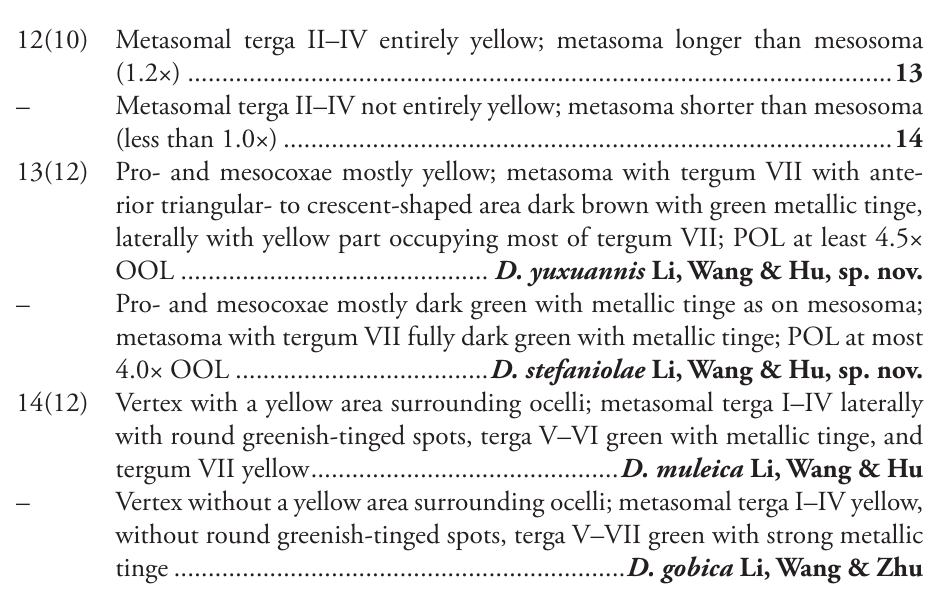
Metasomal terga II–IV entirely yellow; metasoma longer than mesosoma – Metasomal terga II–IV not entirely yellow; metasoma shorter than mesosoma (less than 1.0×) ......................................................................................... 14 Pro- and mesocoxae mostly yellow; metasoma with tergum VII with ante- rior triangular- to crescent-shaped area dark brown with green metallic tinge, laterally with yellow part occupying most of tergum VII; POL at least 4.5× – Pro- and mesocoxae mostly dark green with metallic tinge as on mesosoma; metasoma with tergum VII fully dark green with metallic tinge; POL at most 4.0× OOL ..................................... D. stefaniolae Li, Wang & Hu, sp. nov. 14(12) Vertex with a yellow area surrounding ocelli; metasomal terga I–IV laterally with round greenish-tinged spots, terga V–VI green with metallic tinge, and tergum VII yellow ............................................. D. muleica Li, Wang & Hu – Vertex without a yellow area surrounding ocelli; metasomal terga I–IV yellow, without round greenish-tinged spots, terga V–VII green with strong metallic tinge .................................................................. D. gobica Li, Wang & Zhu Species treatment Dzhanokmenia stefaniolae Li, Wang & Hu, sp. nov. http://zoobank.org/9E38CB14-AF1C-4915-A0C7-749956F29057 Figs 1–12 Description. Female (holotype, Figs 1–6). Body length 2.1 mm; Head with metallic tinge, vertex with small yellow area outside of each posterior ocellus, and with a triangular yel- low T-shaped area in front of anterior ocellus; eye red; ocelli dark red; antenna with scape, pedicel and flagellum yellow; mandible dark brown. Mesosoma green with strong metallic tinge. Legs yellow except all coxae mostly dark green with metallic luster, as on mesosoma, and apical tarsomeres brown (Fig. 2). Metasoma with tergum I yellow except for metal- lic tinge in a triangular anteromedial area; terga II–IV entirely yellow; tergum V medially with a round green or orange metallic pattern; tergum VI mostly with green metallic tinge, laterally with small yellow part round like, yellow part not large than metallic tinge area; tergum VII fully dark green with metallic tinge. Ovipositor black with green metallic tinge; hypopygium fully black with green metallic tinge; outer plate of ovipositor mostly black. Head (Fig. 3) 1.1× as wide as high, 1.5× as wide as midlobe of mesoscutum. Ocel- lar triangle surrounded by shallow grooves (vertex collapses along these lines in air- dried specimens). POL 3.8× OOL. Torulus at lower margin of eye. Malar space about 0.4× eye height. Malar sulcus strongly curved. Antenna (Fig. 4) with scape 4.0× as long as wide, not reaching anterior ocellus; pedicel 1.6×, F1 1.6×, F2 1.5×, F3 1.0×, and clava 1.9× as long as wide; C3 short with rounded apex, without a terminal